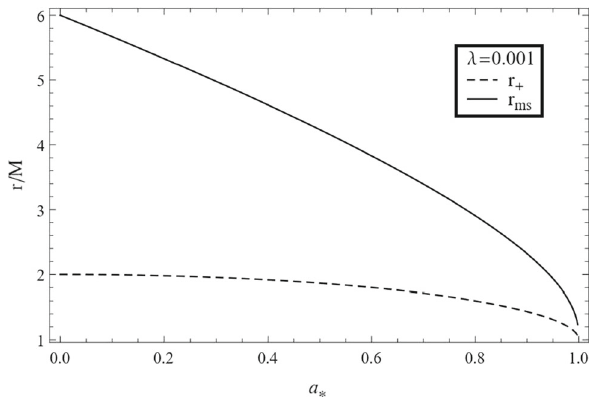
Fig. 1 The value of the radial coordinate for the throat r + (dashed line) and marginally stable r ms (solid line) orbits as functions of the spin parameter a (cid:4) for the λ = 10 −